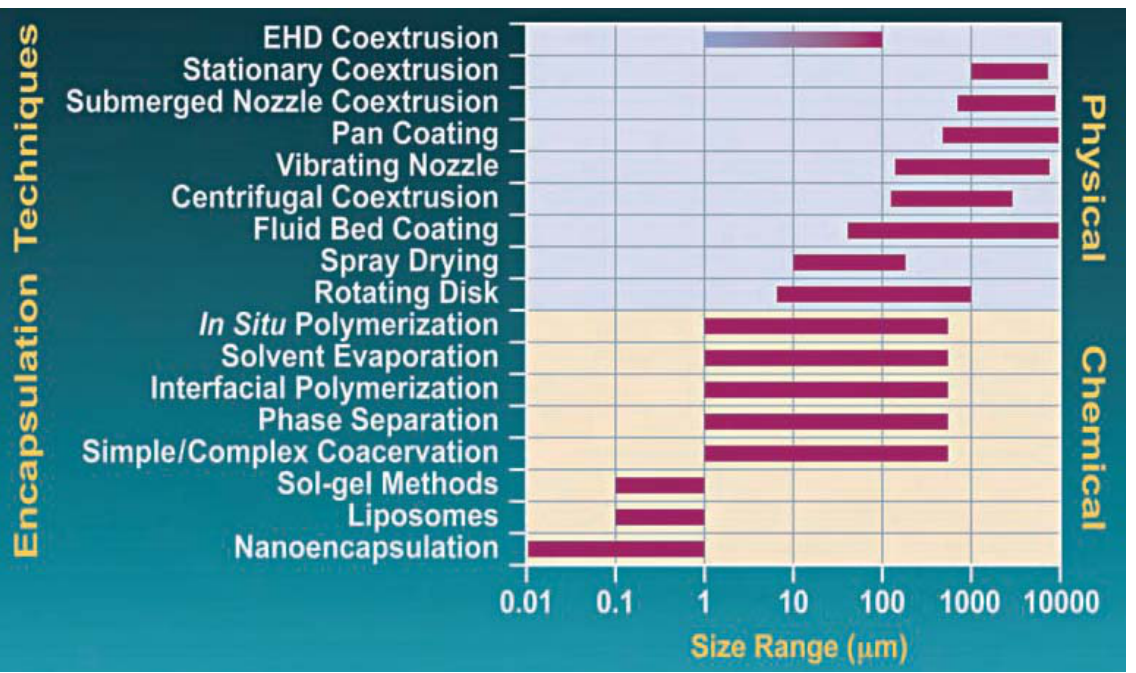
Figure 1. The correlation between the microcapsule size and the fabrication